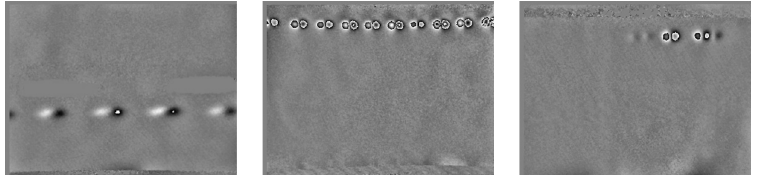
Figure 6. Speckle interference tire bubble defects example. These are some instances in the dataset, and the places with higher gray values in the image are bubbles.